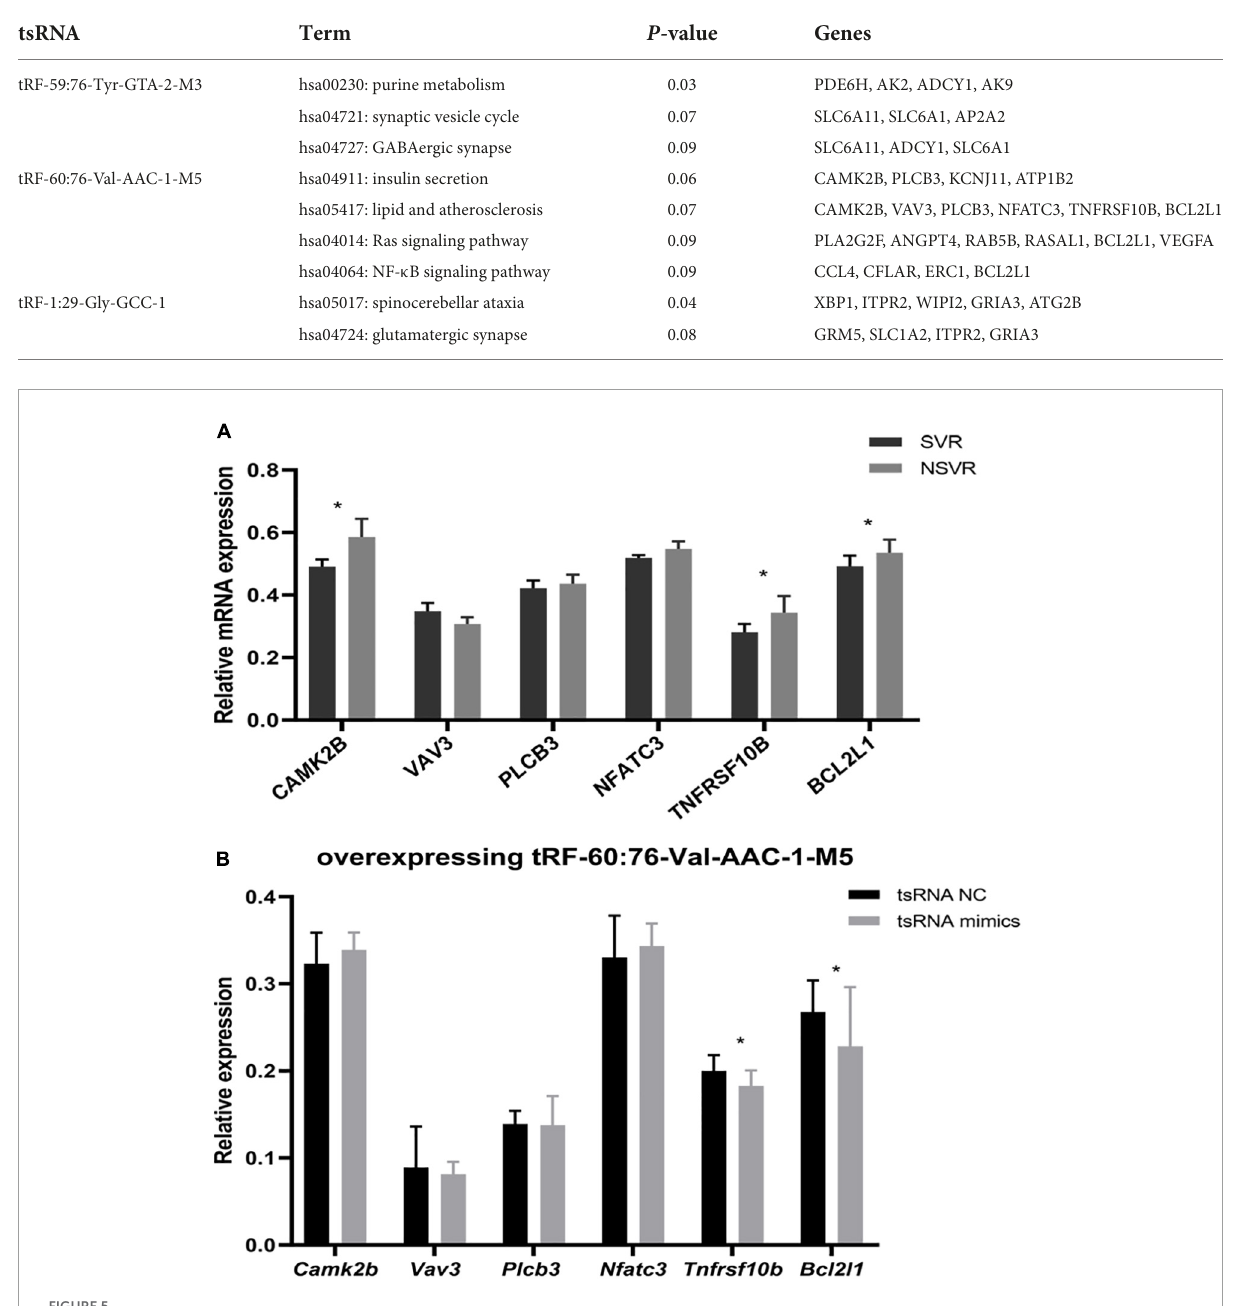
FIGURE5 tRF-60:76-Val-AAC-1-M5-targeted genes enriched in lipid signal pathways and atherosclerosis after transfection. (A) Differences in mRNA expression between SVR and NSVR patients. (B) Relative mRNA levels after the transfection of HUVECs with tRF-60:76-Val-AAC-1-M5. Data are presented as the mean ± SD ( n = 3 each group), * P < 0.05 indicate significant differences relative to the group of tsRNA